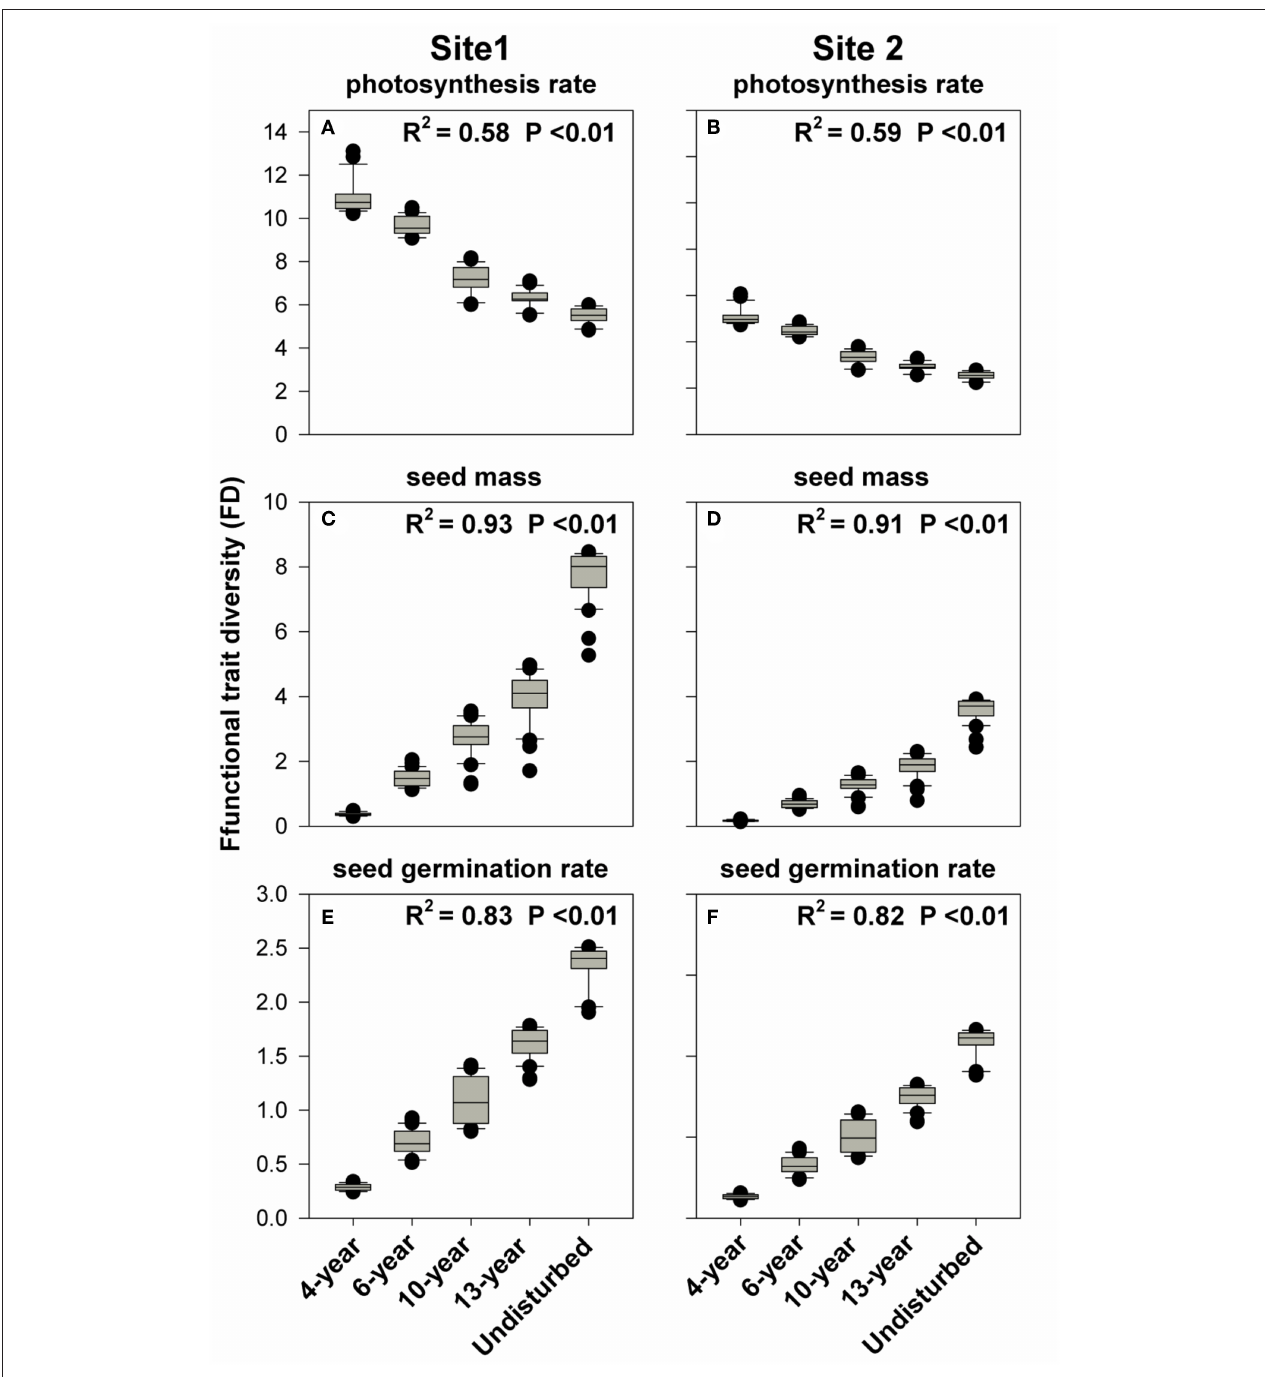
FIGURE 3 | The variations in FD for photosynthesis rates, seed mass, and seed germination rates for the successional meadows. (A,C,E) Represent FD for photosynthesis rate, seed mass, and seed germination rate in chronosequence 1, respectively. Likewise, (B,D,F) indicate FD for photosynthesis rate, seed mass, and seed germination rate in chronosequence 2